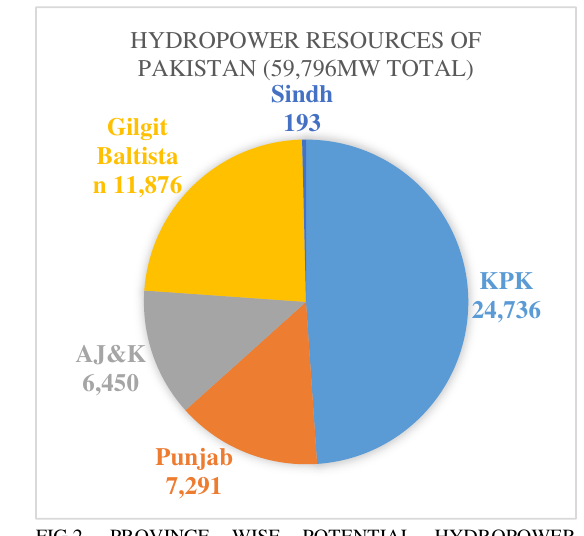
FIG.2. PROVINCE WISE POTENTIAL HYDROPOWER RESOURCES (CALCULATED FROM